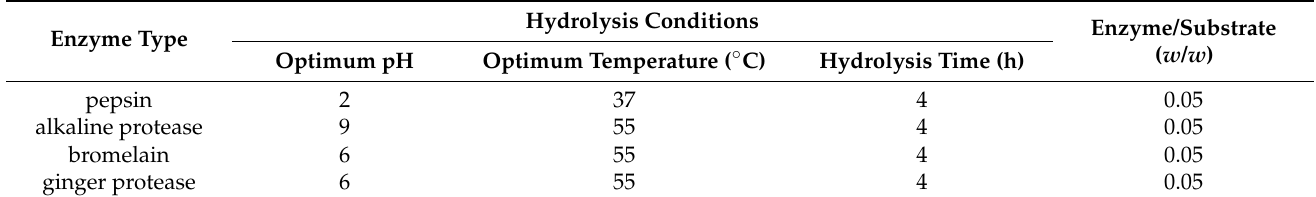
Table 7. The optimal conditions for the hydrolysis of fish skin gelatin by different enzymes. Hydrolysis Enzyme Type